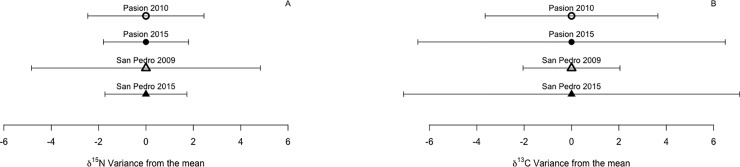
Variance from the mean of isotopes values in fecal samples from Neotropical river otters for (A) 𝛿15N and (B) 𝛿13C. The mean is set to 0 to help visualize the magnitude of the variances. Pasion River n = 36 in 2010 and 34 in 2015; San Pedro River n = 20 in 2010 and 55 in 2015.